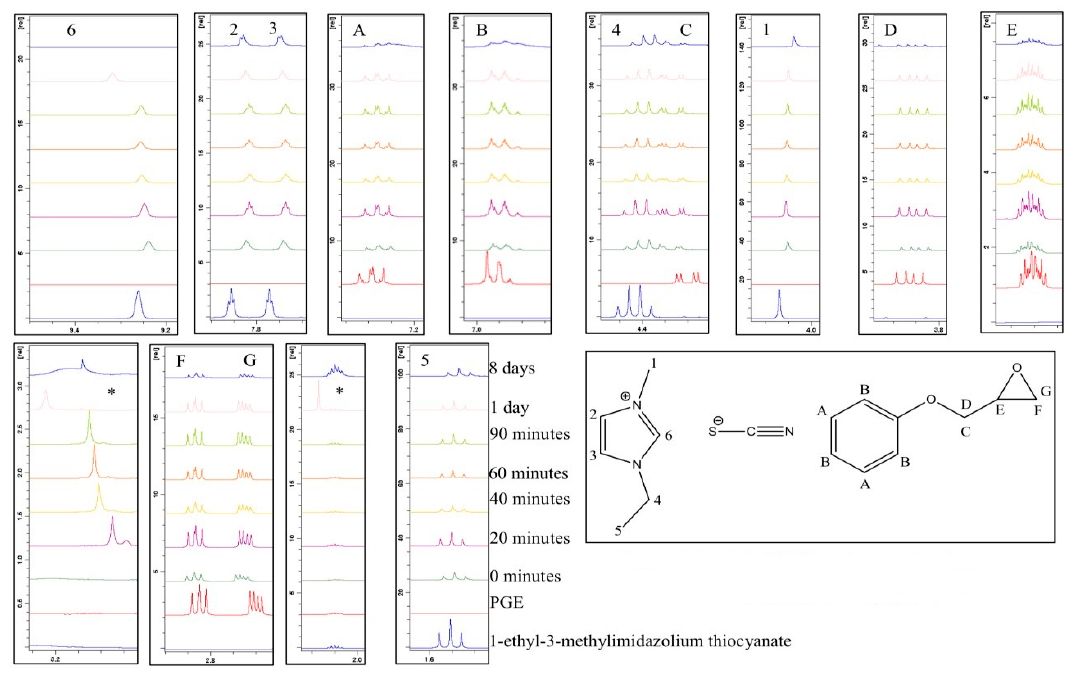
Figure 8. Expanded overlaid 1 H NMR spectra of a room-temperature-stored 1:1 formulation of PGE and 1-ethyl-3-methylimidazolium thiocyanate.